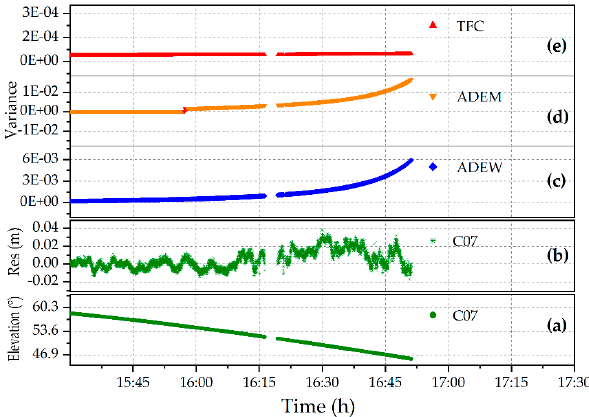
Figure 9. DD residuals and the elevation time series of C07, as well as the corresponding variance in the different models: ( a ) elevation angle; ( b ) DD residuals; and variance in ( c ) ADEW; ( d ) ADEM; and ( e ) TFC.